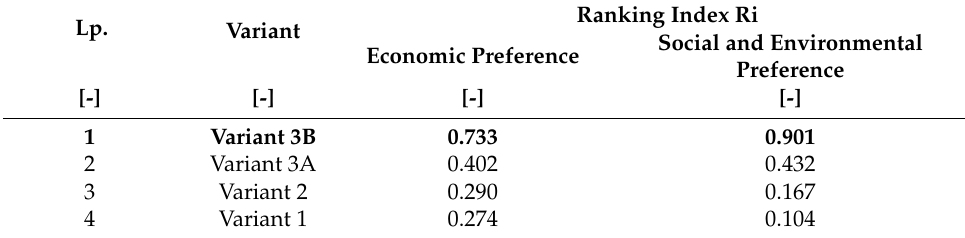
Table 12. Final ranking of